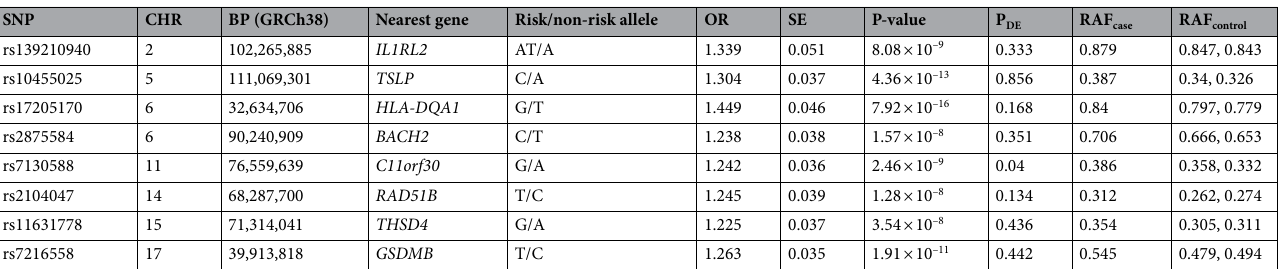
Table 1. Sentinel variants in eight regions significantly associated with moderate-to-severe asthma risk in this GWAS of 3181 cases and 3590 controls (OR = odds ratio for coded allele, SE = standard error, P DE = p-value for the differential effects test, RAF = risk allele frequency for AMD and RA controls,